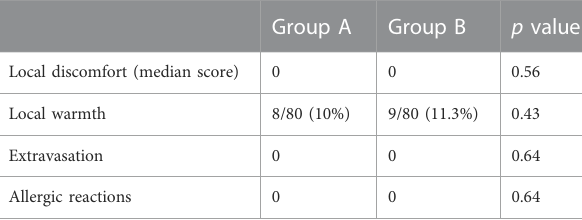
TABLE 4 Local discomfort at the injection site of two